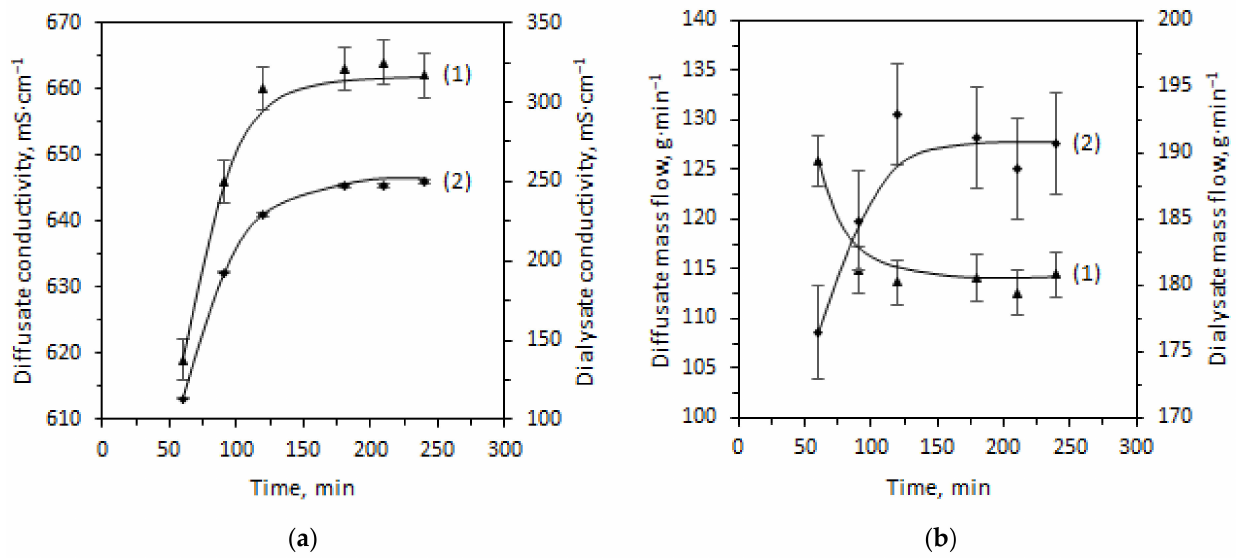
Figure 1. Electrical conductivity ( a ) and mass flowrate ( b ) of the output streams for Test 1 over time; (1) ( ▲ ) diffusate, (2) ( ◆ )